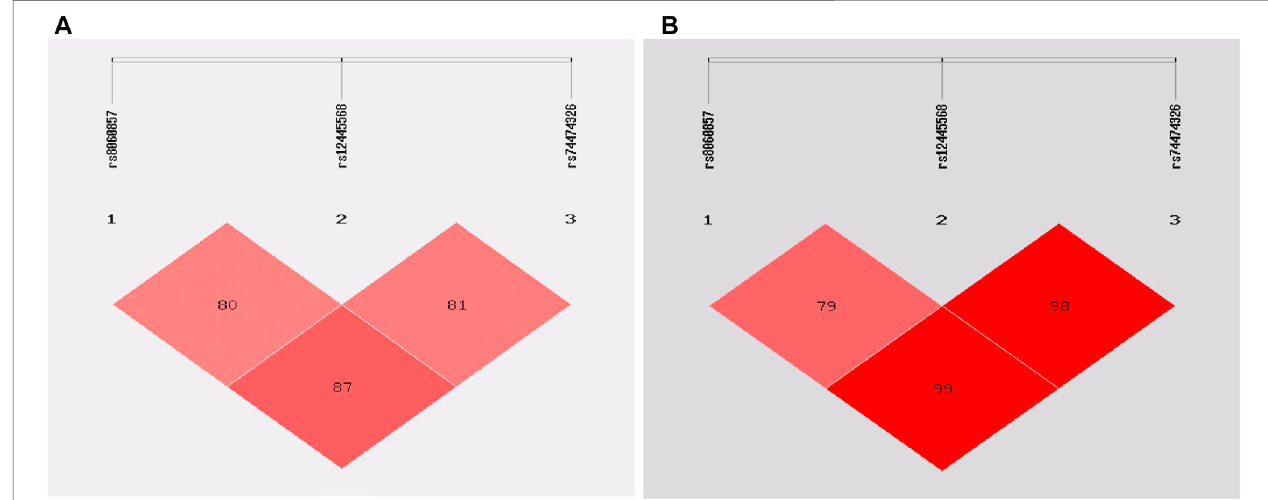
FIGURE 1 | Linkage disequilibrium (LD) analysis of the STX1B SNPs in cases and controls: (A) in epilepsy patients and controls (B) in drug-resistant epilepsy patients and drug-responsive patients.